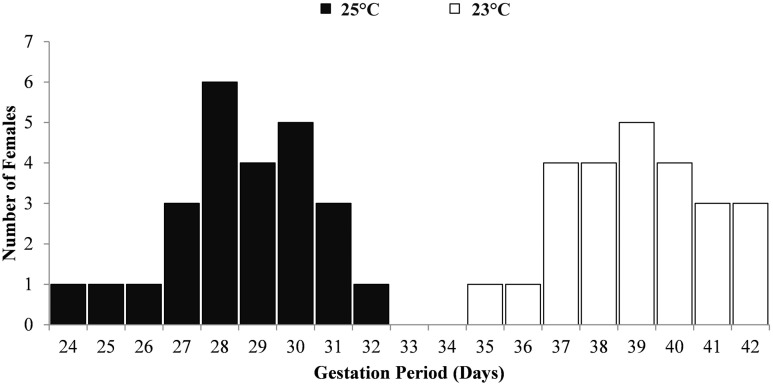
Gestation period of G. holbrooki at two different rearing temperatures.